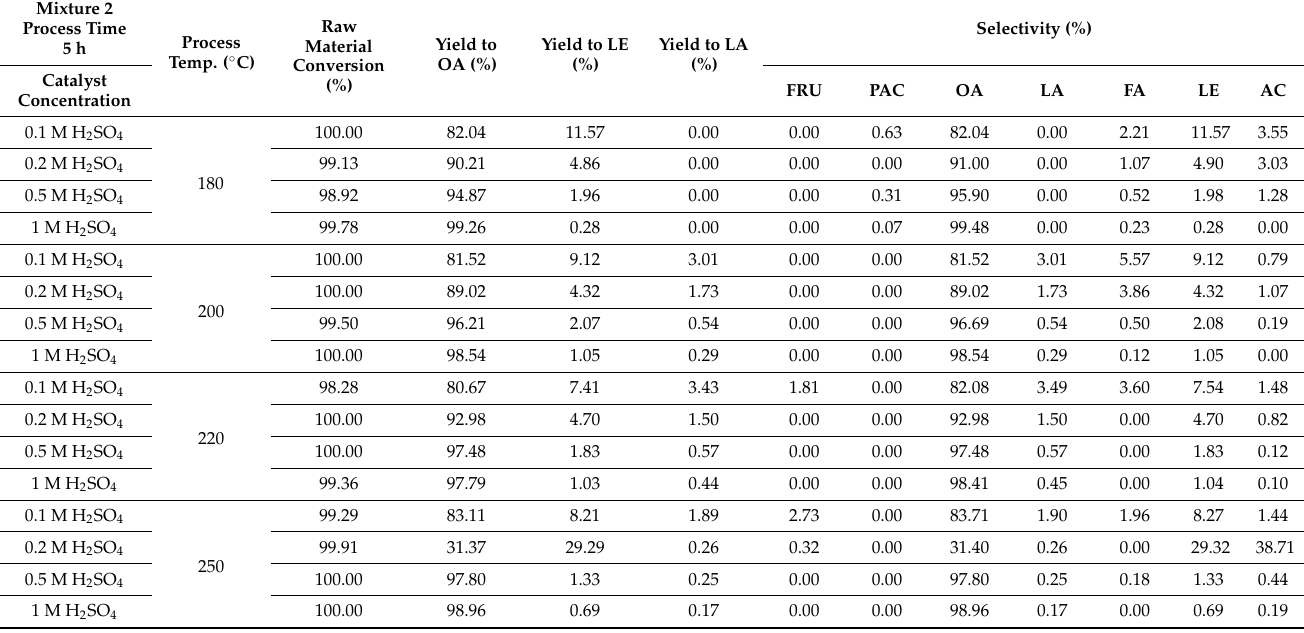
Table 5. The results of HPLC analysis for the catalytic conversion of hemicellulose